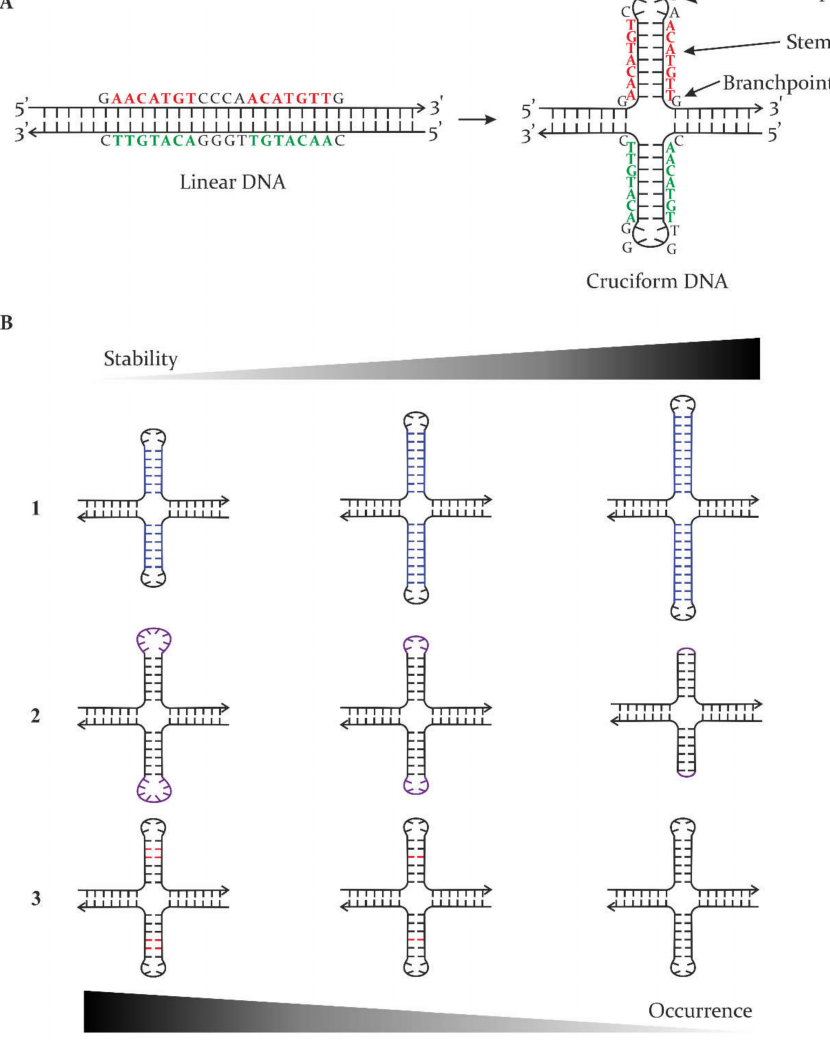
Figure 1. Inverted repeat sequences can form different types of double-stranded